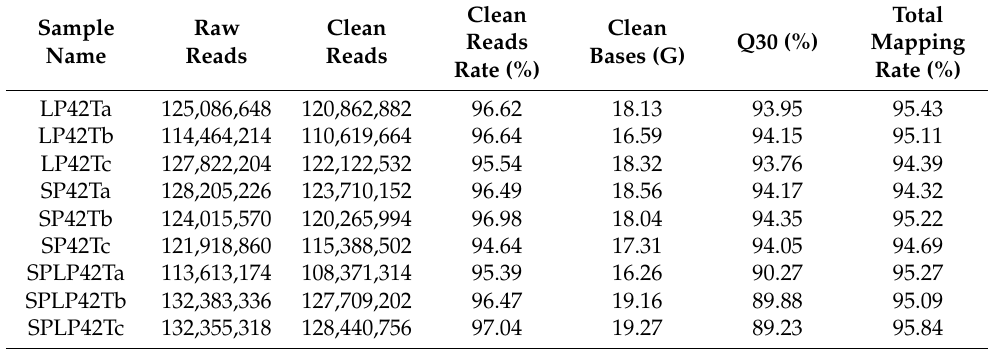
Table 1. Summary of raw reads after quality control and mapping to the reference genome.